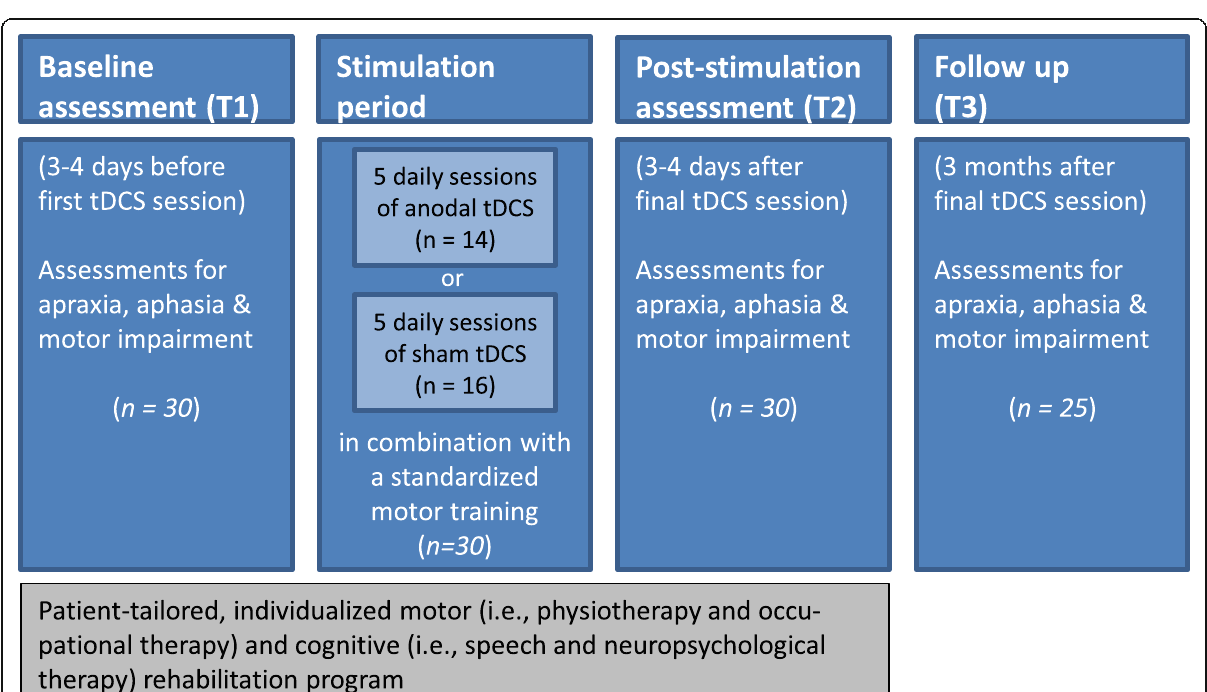
Fig. 2 The study design consisted of a baseline assessment (3 – 4 days before first tDCS session), the stimulation period (comprising 5 daily session of either anodal or sham tDCS applied above left posterior parietal cortex, PPC, combined with motor training by three motor tasks, see text), and the post-stimulation assessment (3 – 4 days after final tDCS session). While all 30 LH stroke patients underwent these three study parts, 25 LH stroke patients performed a follow-up assessment, about 3 months after the final tDCS session. The apraxia and aphasia assessments focused on the Cologne Apraxia Screening (KAS) and the short version of the Aphasia Check-List (ACL-K). Grip force measures reflected the motor impairment. As depicted by the grey box, the baseline assessment, the stimulation period, and the post-stimulation assessment took place while the 30 patients were hospitalized for stroke rehabilitation undergoing a patient-tailored, individualized motor (i.e., physiotherapy and occupational therapy) and cognitive (i.e., speech and neuropsychological therapy) rehabilitation